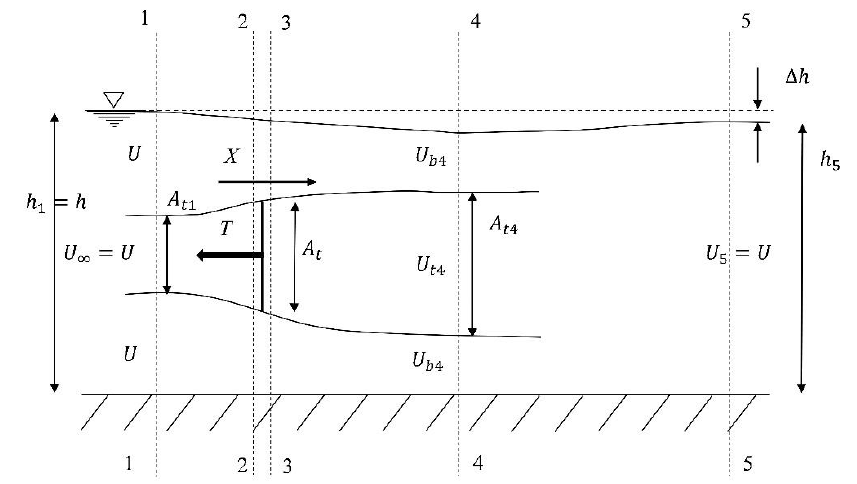
Figure A1. Blockage correction: Schematic of a tidal turbine in an open surface water channel environment.